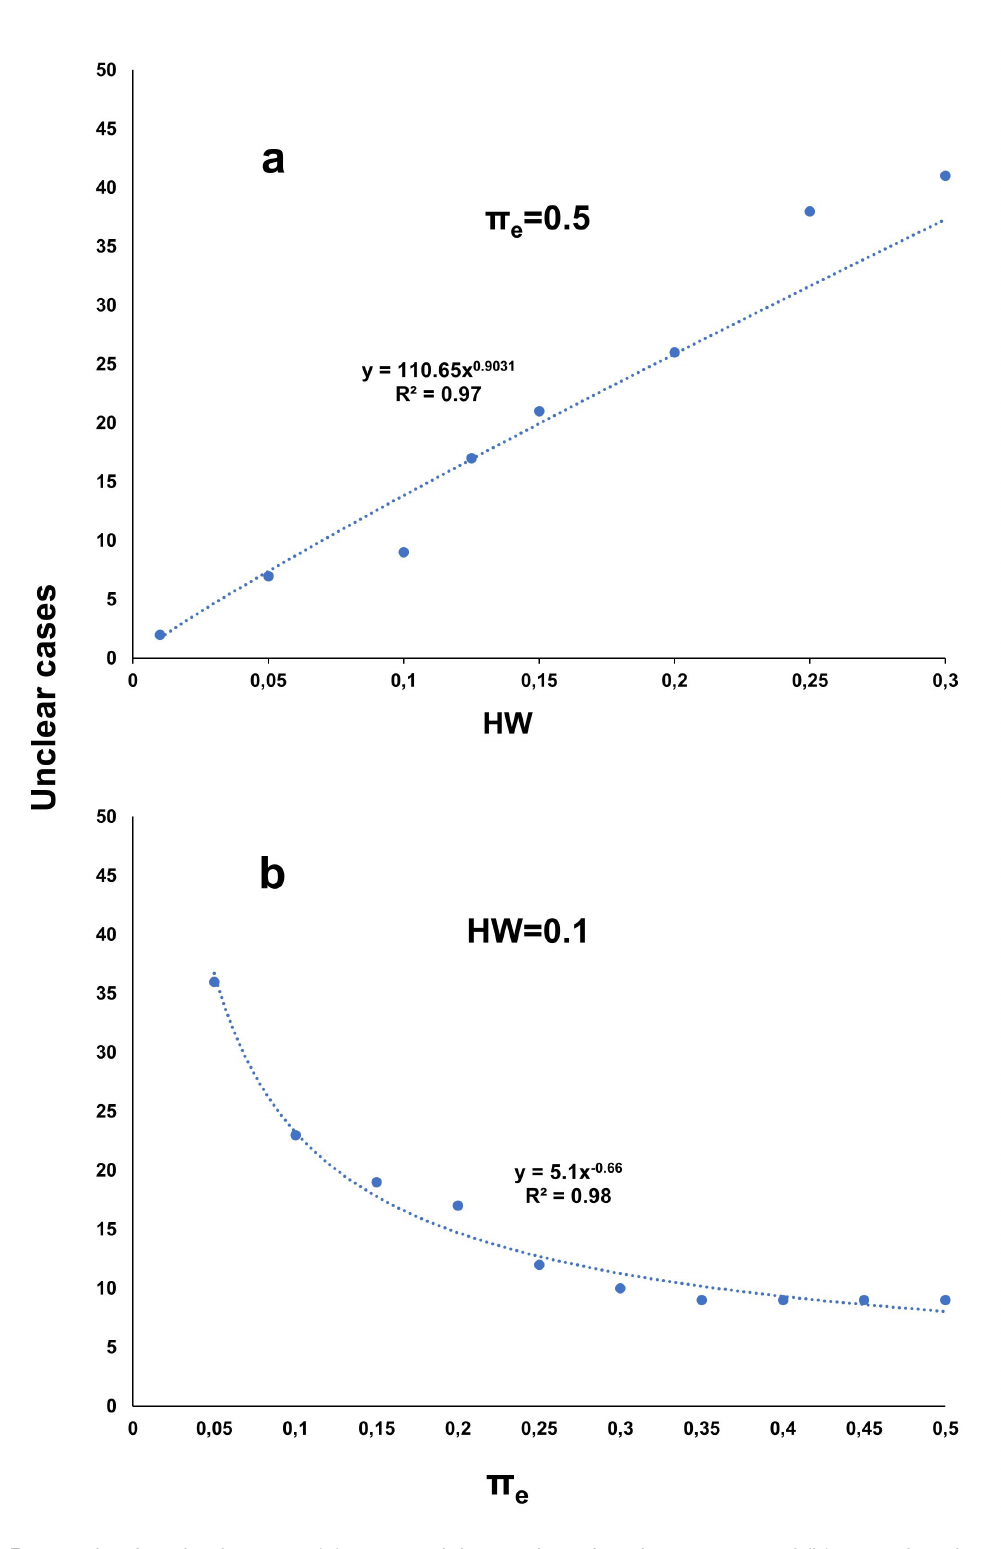
Figure 10. Regression function between (a) HW and the number of unclear cases, and (b) π e and unclear cases, using the same data from Figure 9 (more scenarios were considered than shown in Figure 9). In (a) π e is kept constant at 0.5, while in (b) the HW is constant at 0.1. For both HW and π e , we have a very high coefficient of determination R 2 , but for HW we have an almost linear correlation, while for π e we have a power function with a less steep slope. In (b) from π e = 0 . 35 to 0 . 5 , the number of unclear cases remains